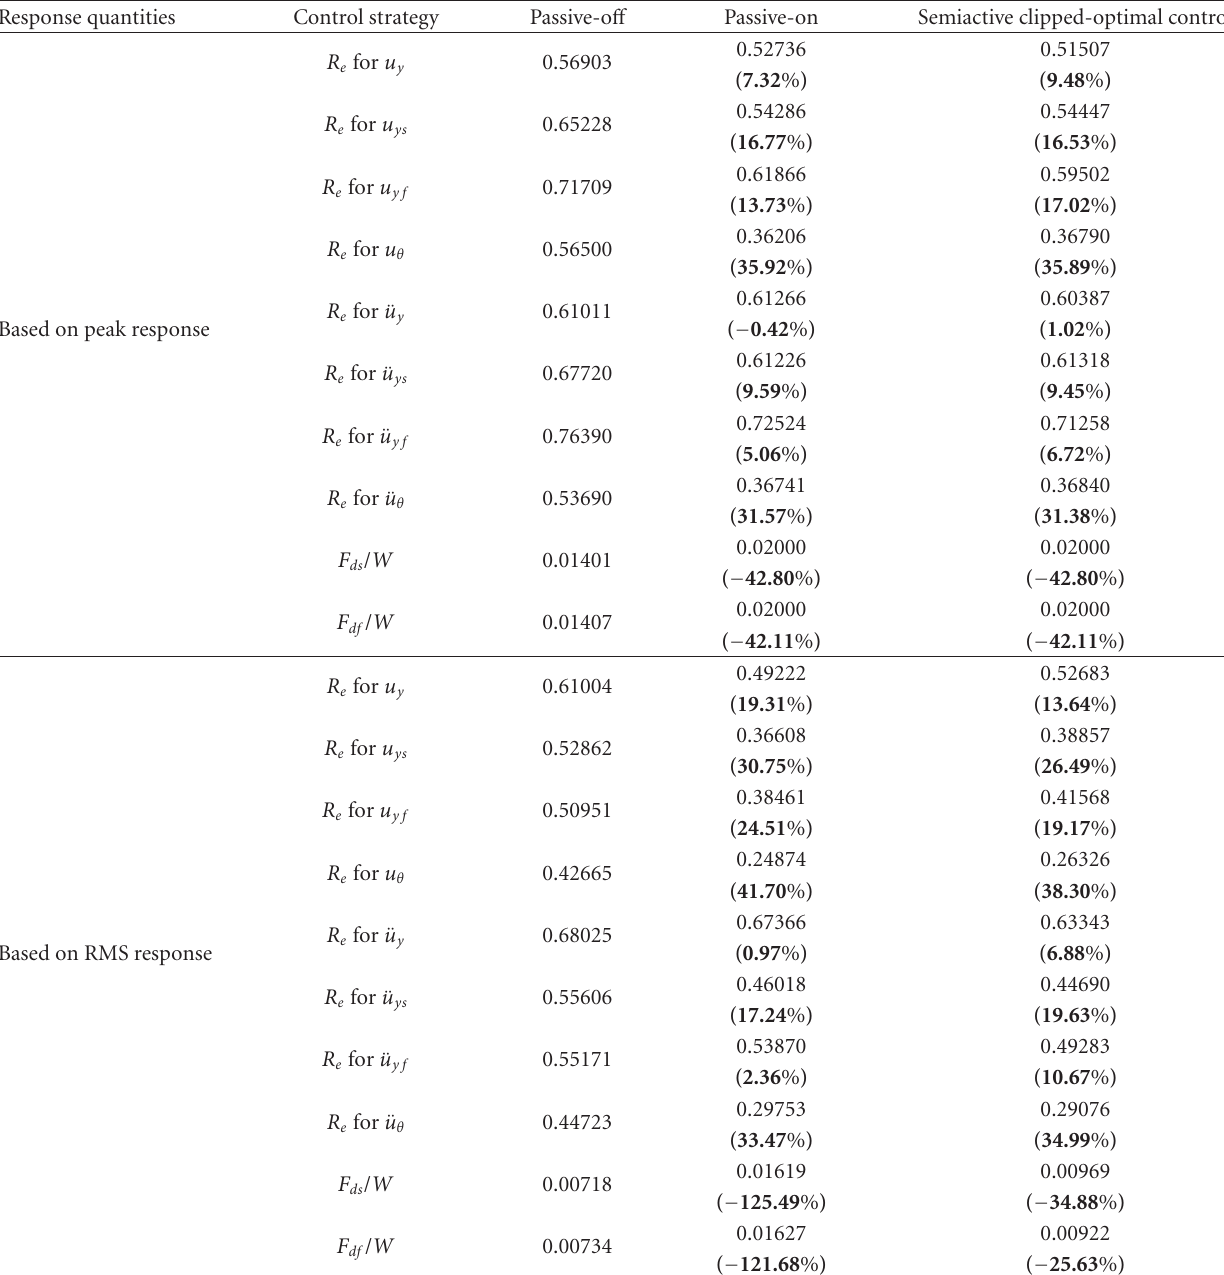
Table 3: Response ratio, R e for Peak and RMS Responses for various control strategies under Imperial Valley, 1940 earthquake ( T y = 1, Ω = 1, e = 0 . θ x / r